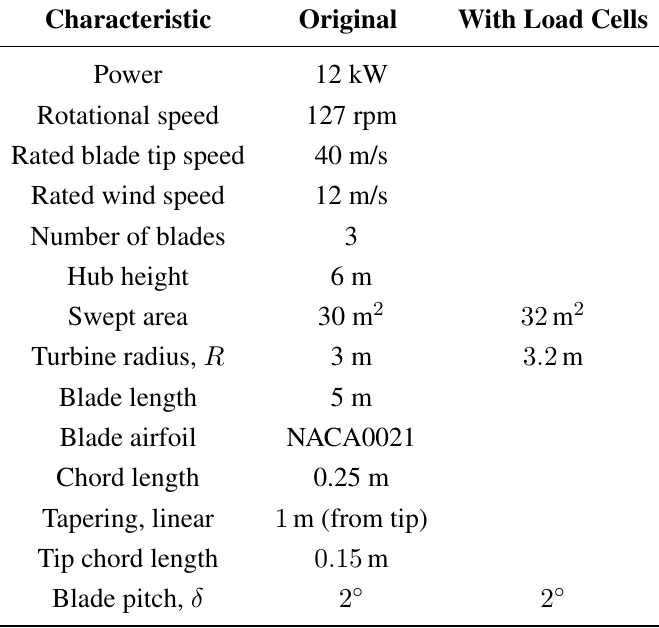
Table 2. The turbine